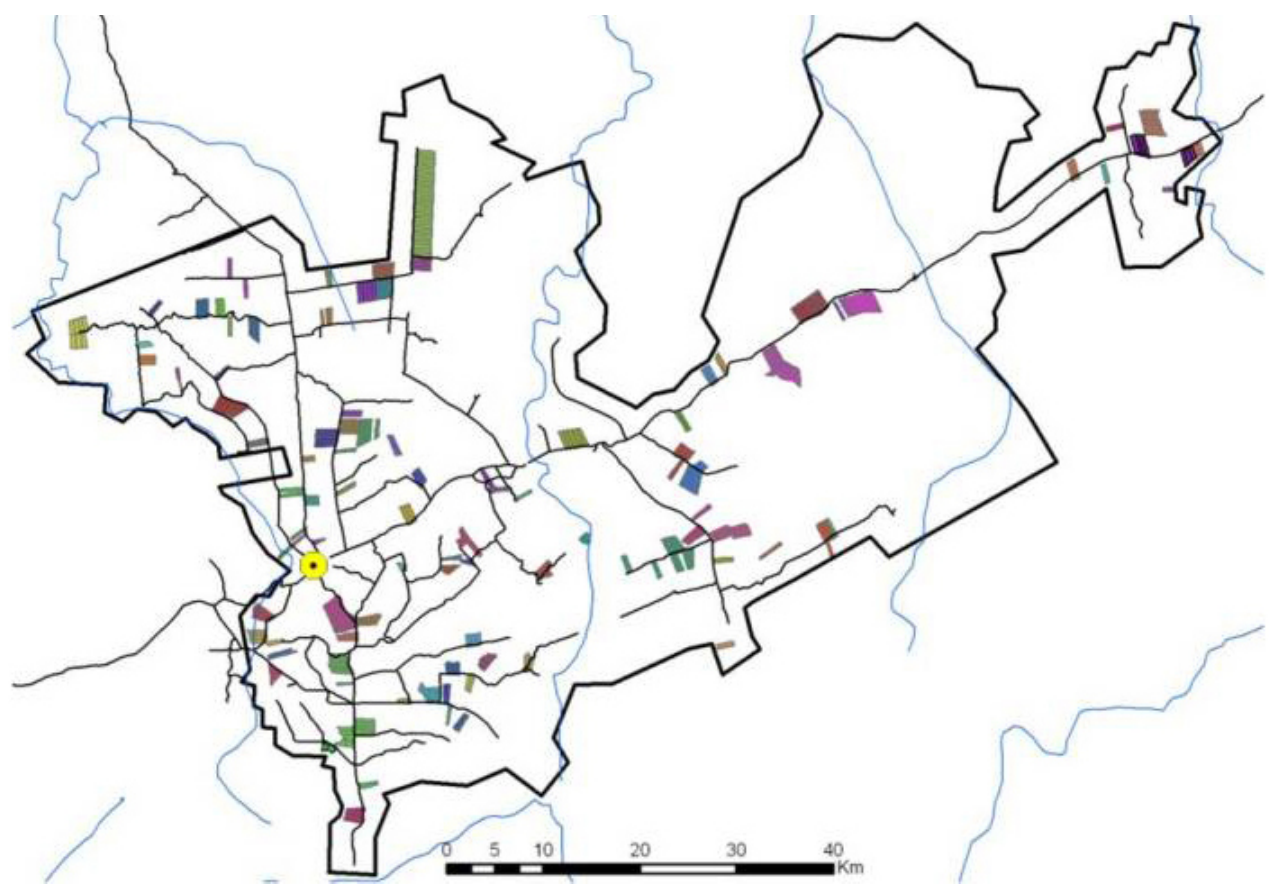
Fig. 2 . The set of selected properties. Different colors represent each of the